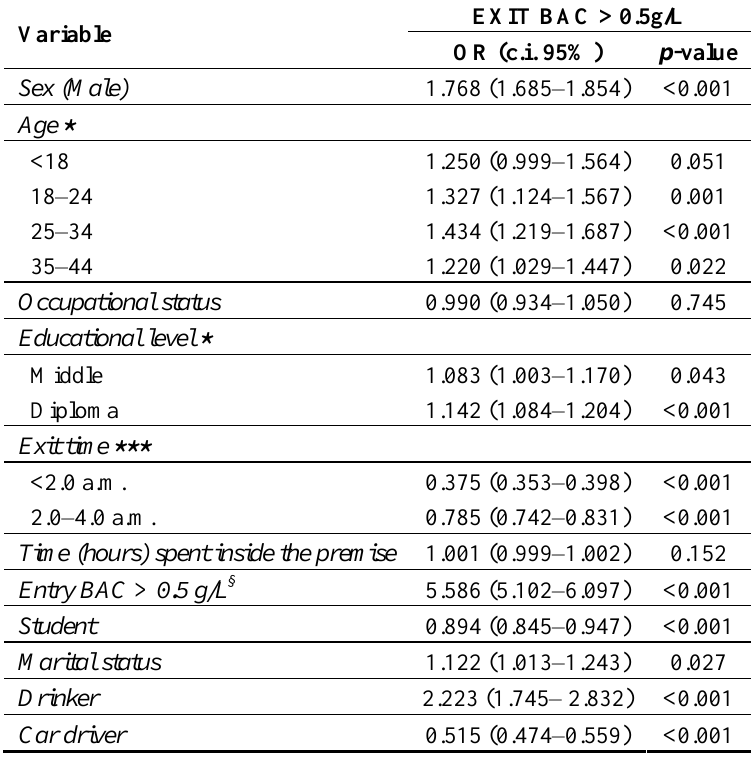
Table 4. Logistic regressions to assess the contribution, in terms of odds ratio, of each sociodemographic and environmental characteristics of BAC beyond the legal limit at the exit from the discos (or other recreational